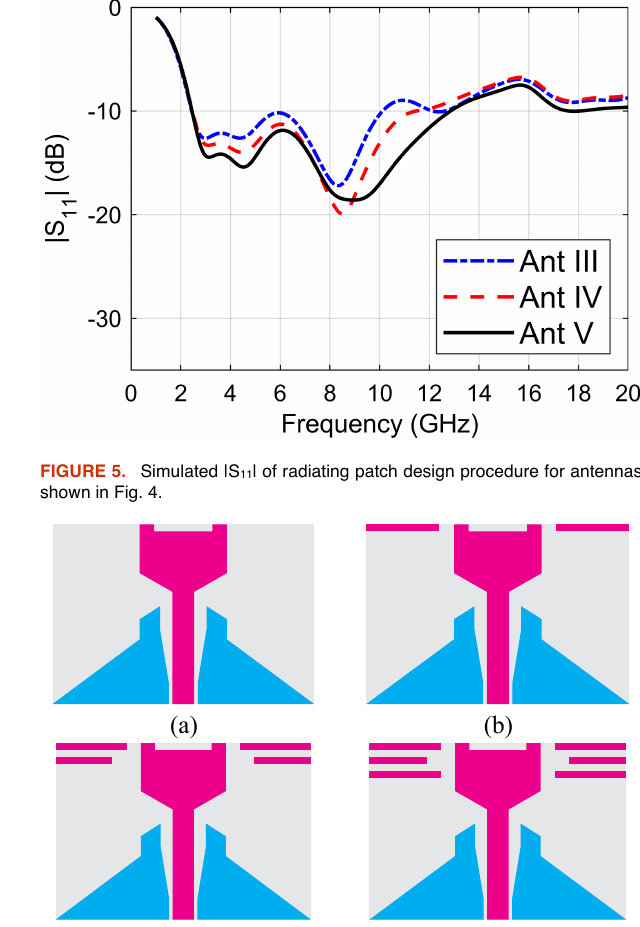
FIGURE 6. Parasitic elements design steps: (a) Ant V, (b) Ant VI, (c) Ant VII, and (d) proposed antenna (Ant